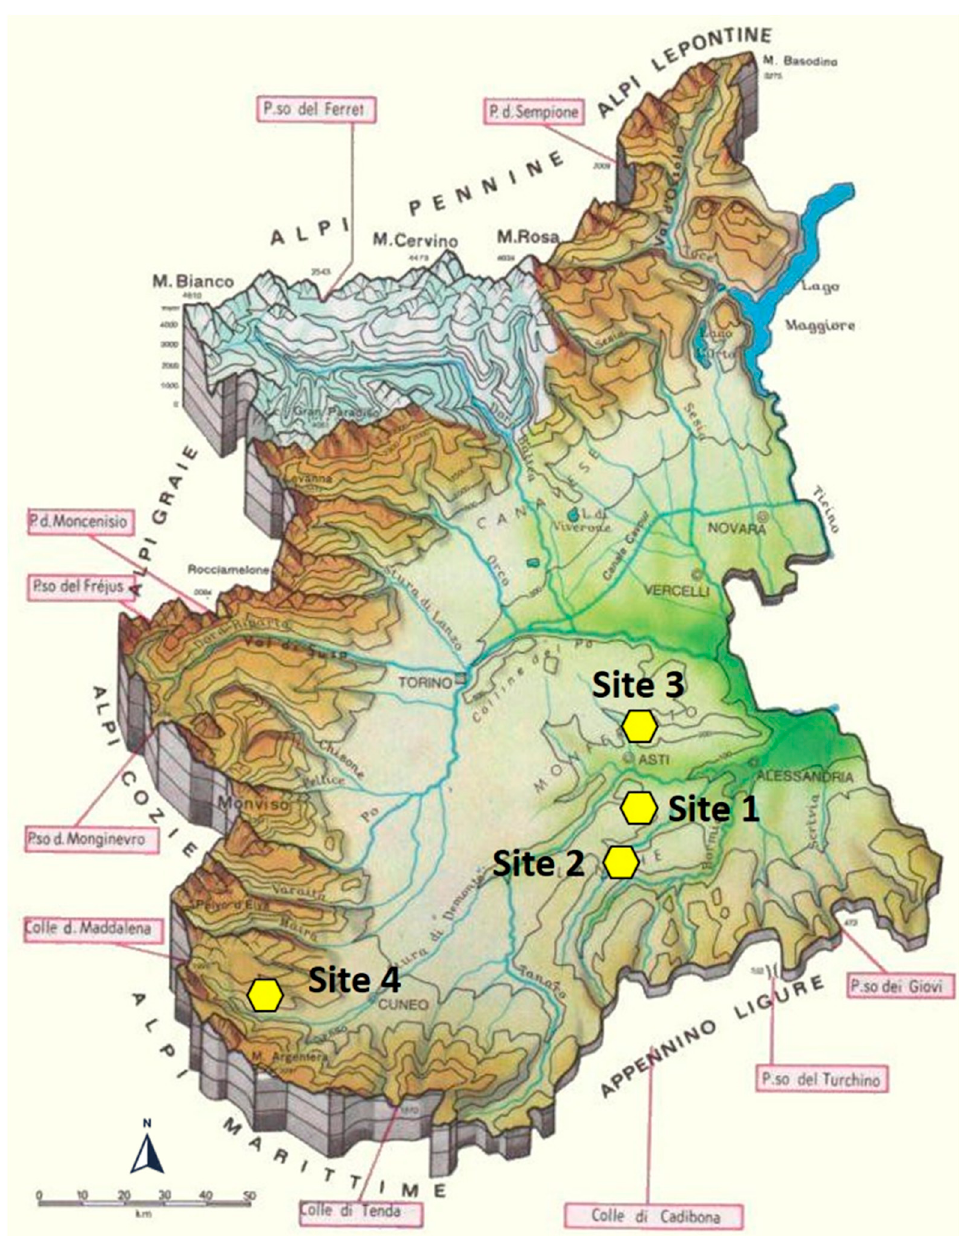
Figure 1. Monitored apiaries in Piedmont, Italy.